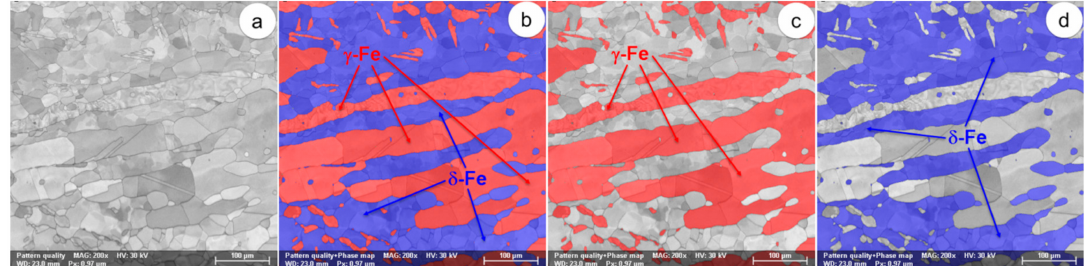
Figure 3. The SEM-EBSD composite images ( × 200) for the as-received UNS S32750 SDSS alloy (the initial microstructural state): ( a ) the microstructure of the analysed field; ( b ) the distribution of phases in the microstructure of the analysed field; ( c ) the distribution of the γ -Fe phase; ( d ) the distribution of the δ -Fe phase.